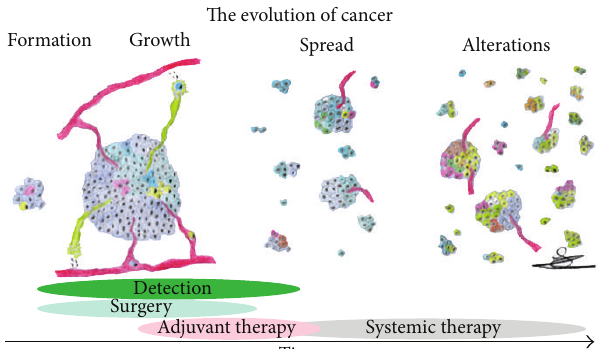
Figure 1: The evolution of cancer. After initial formation of cancer cells, growth of the tumor attracts blood vessels to supply oxygen and nutrients. Cancer cells then spread via these vessels forming metastases at distant sites. Mutations in DNA result in a heterogeneous population of cancer cells, with the potential of an increase in resistance against medicine. Patient care is depicted during the time of this